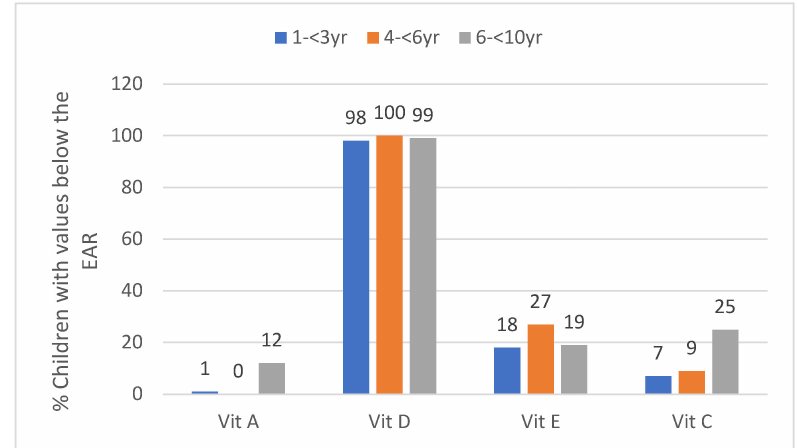
Figure 3. Percent children in the three age groups with values below the estimated average requirement (EAR) for vitamins A, D, E and C (taken to nearest